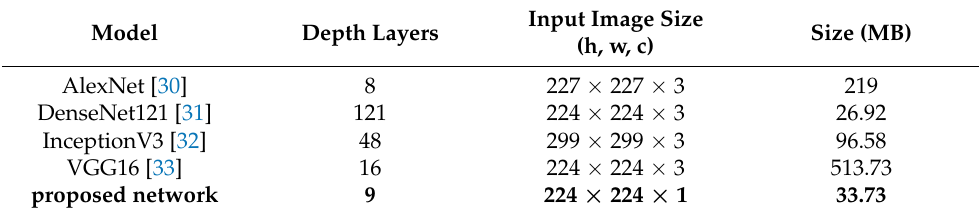
Table 2. The depth, trainable parameters, and size of pre-trained